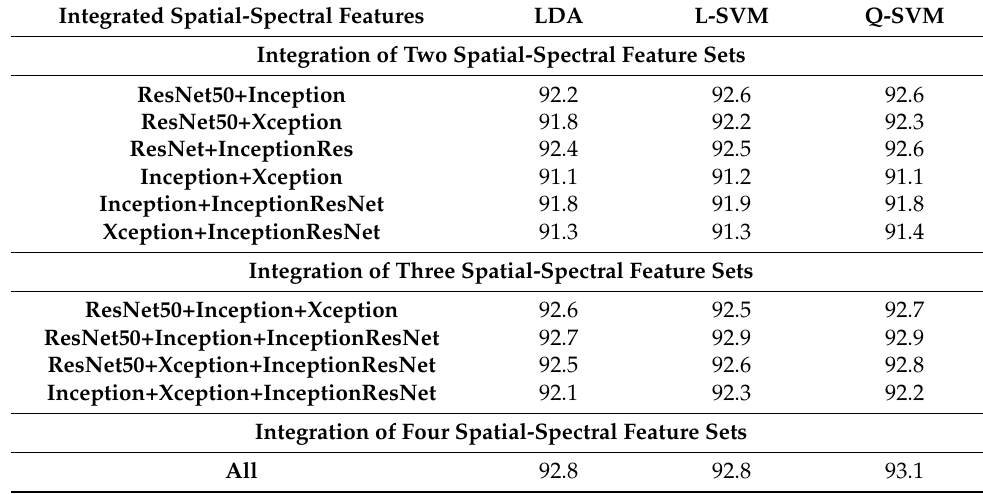
Table 4. The accuracy (%) achieved for the three classifiers trained with integrated spatial-spectral features using